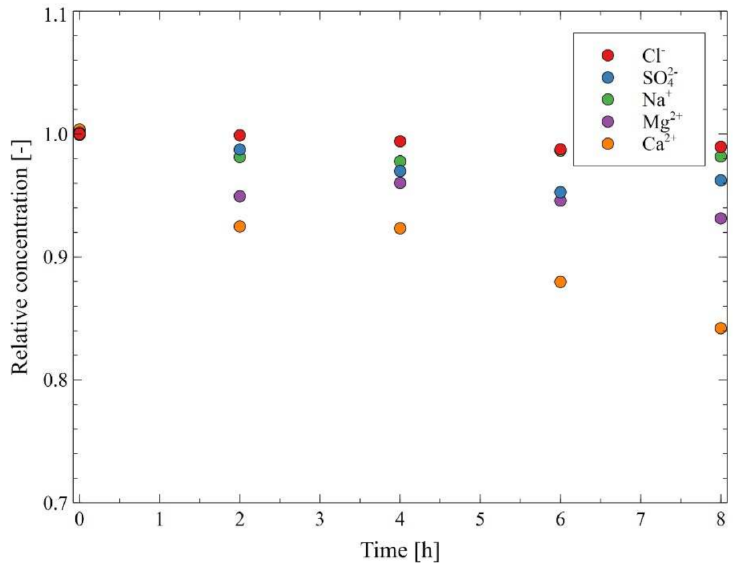
Figure 10. Changes in the composition of the Baltic Seawater during the MD process. T F = 343 K, v F = 0.12 m/s. Module M2.